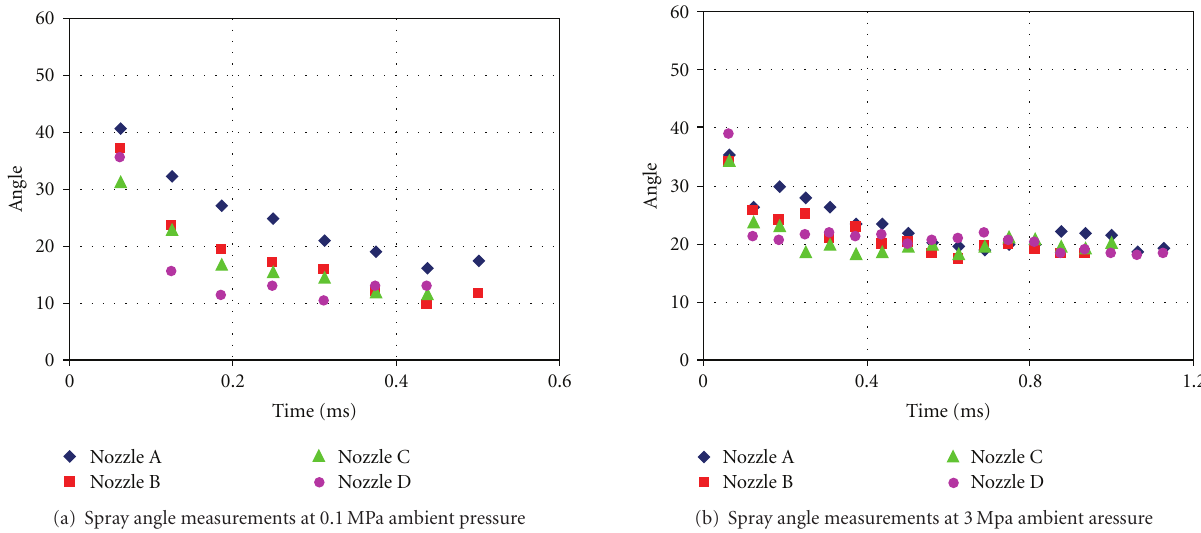
Figure 16: Comparison of spray angle measurement in terms of nozzle type (300 K ambient temperature, 50MPa injection pressure, 1.5 ms injection